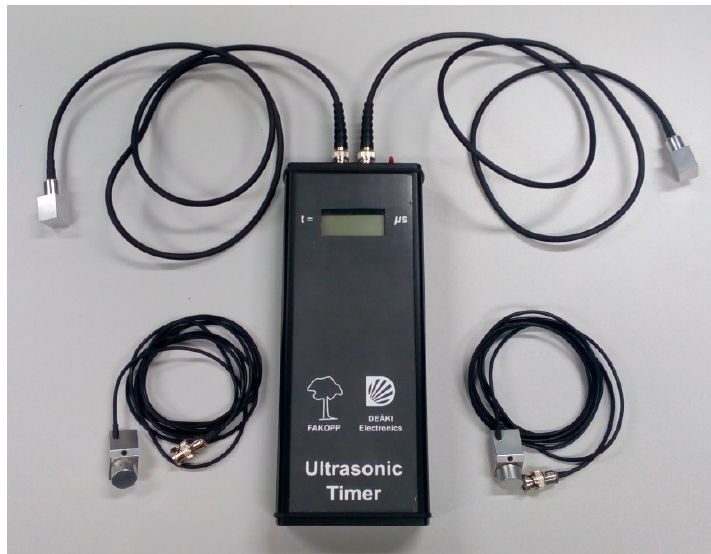
Figure 2. Photo of equipment Ultrasonic Fakopp Timer.